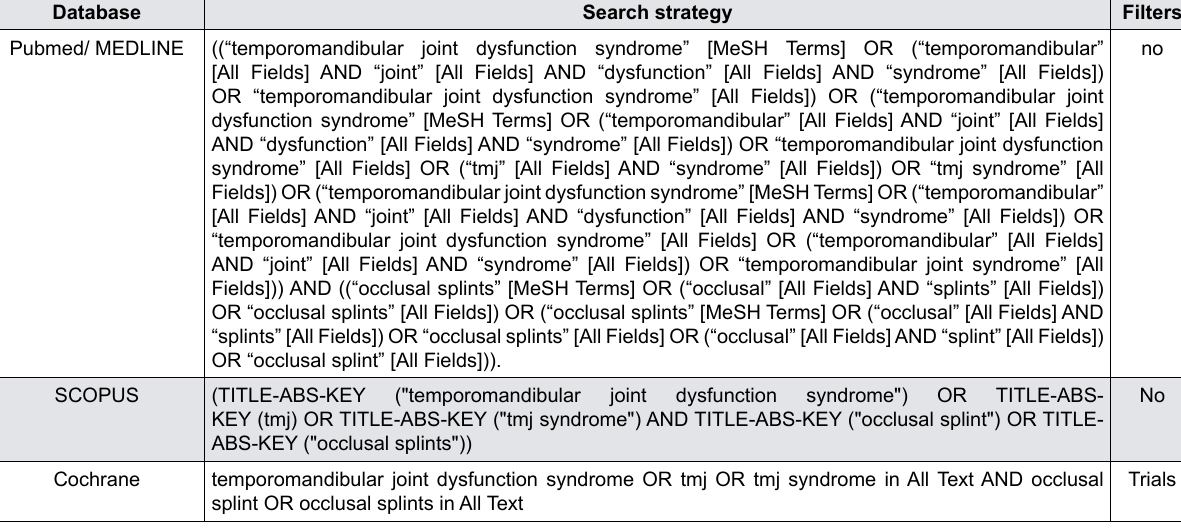
Figure 2- Search strategy for each